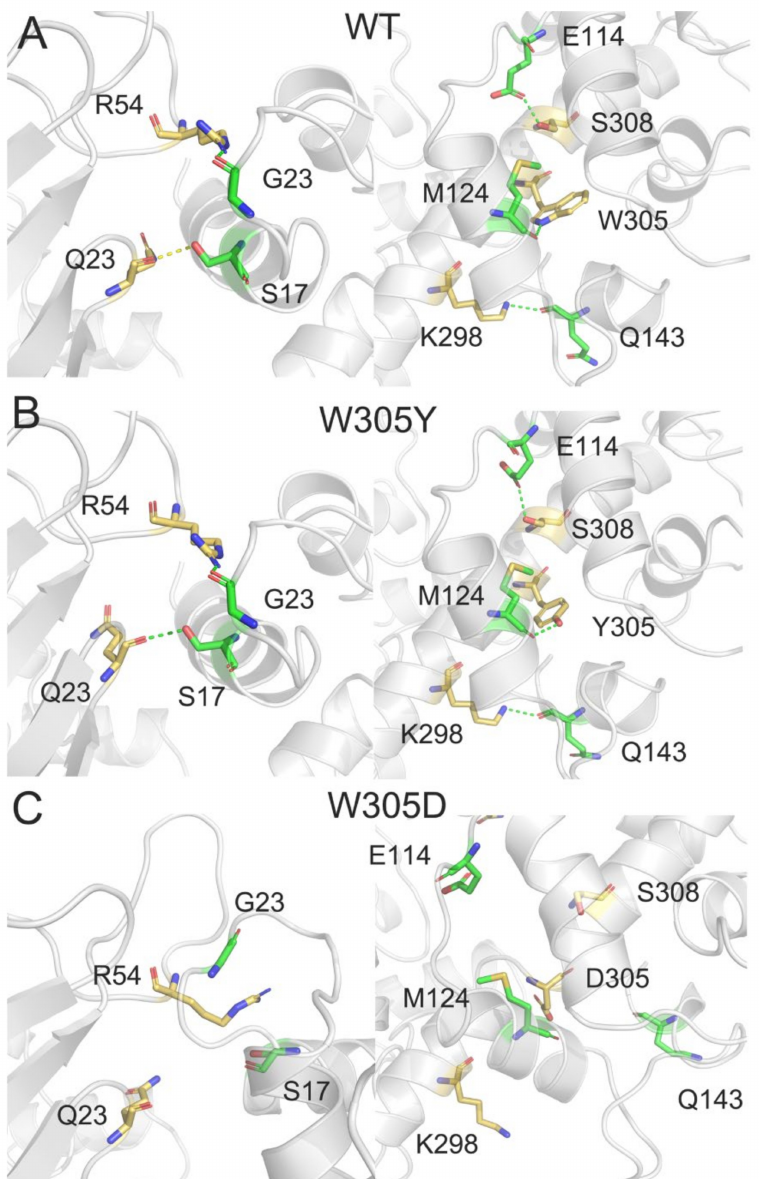
Figure 6. The hydrogen bonds between the interface of DAPK1 and CaM in the WT ( A ), W305Y ( B ), and W305D ( C ) systems. Hydrogen bonds are shown by green dotted lines.